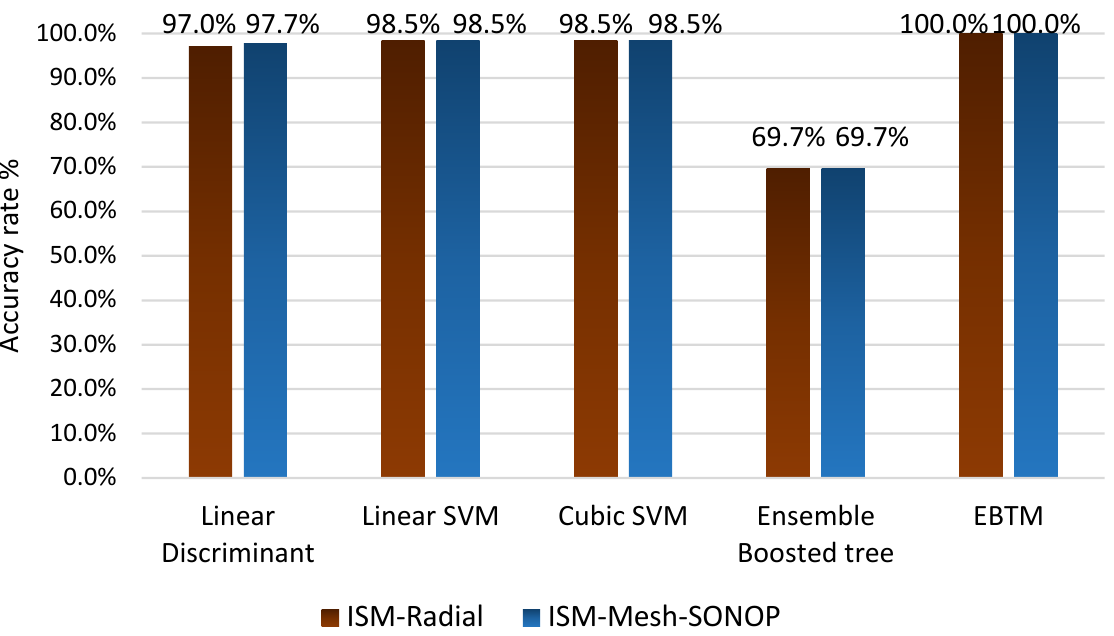
Figure 7. Comparative evaluation of the performance of five MLTs used in this investigation under radial and mesh-SNOP throughout IsM-DN.